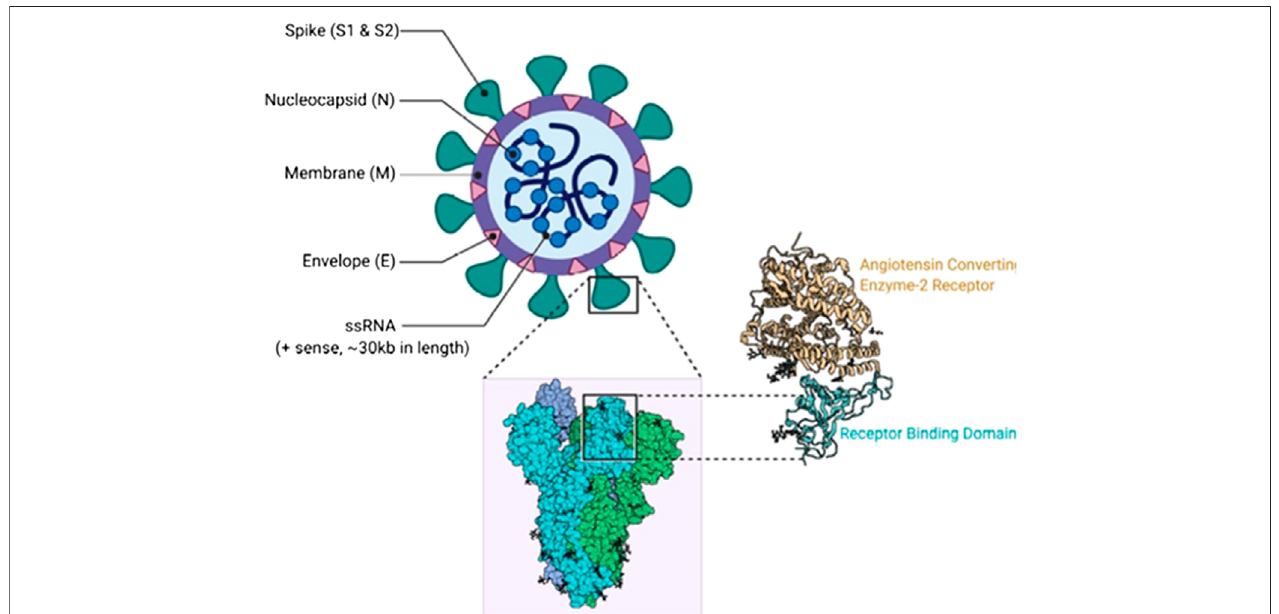
FIGURE 1 | SARS- CoV two Structure (Cascella et al., 2020). Contributed by Rohan Bir Singh, MD; Made with Biorender.com.